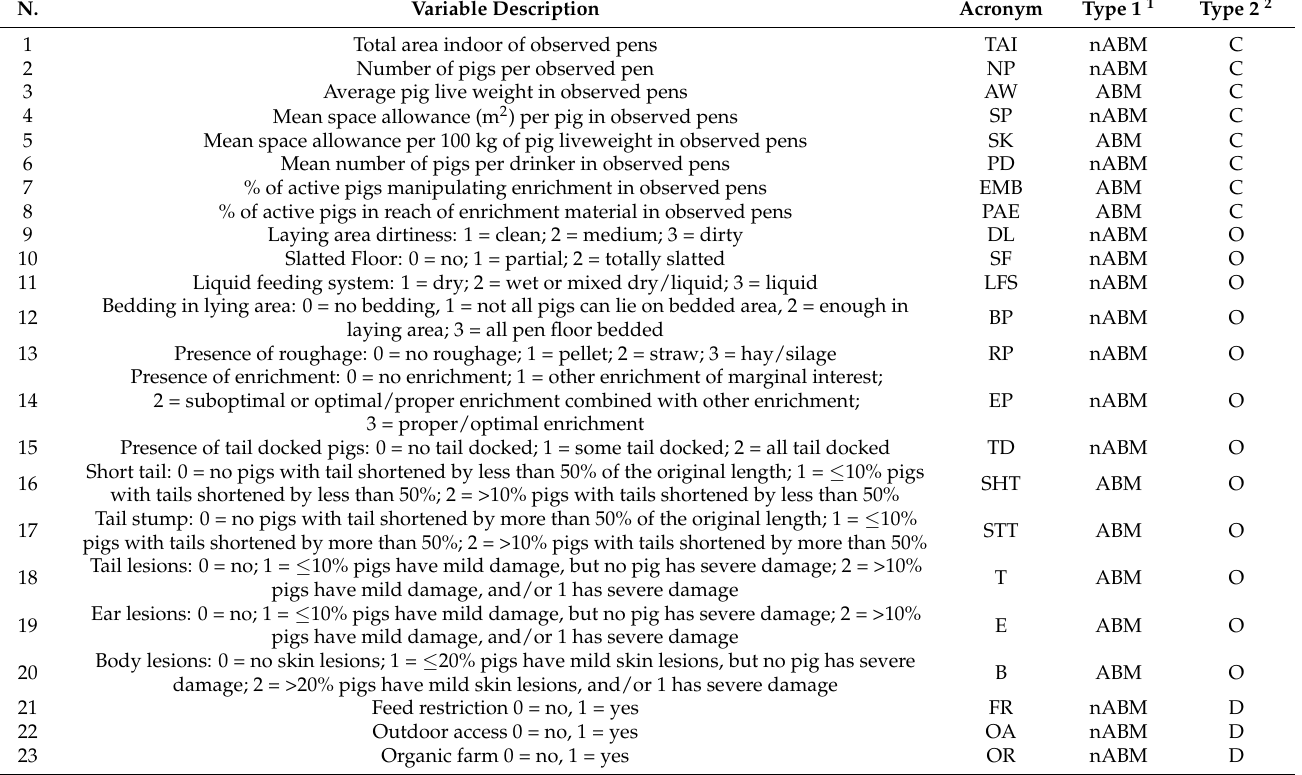
Table 1. Continuous, ordinal, and dichotomous variables for 709 observed pig groups.